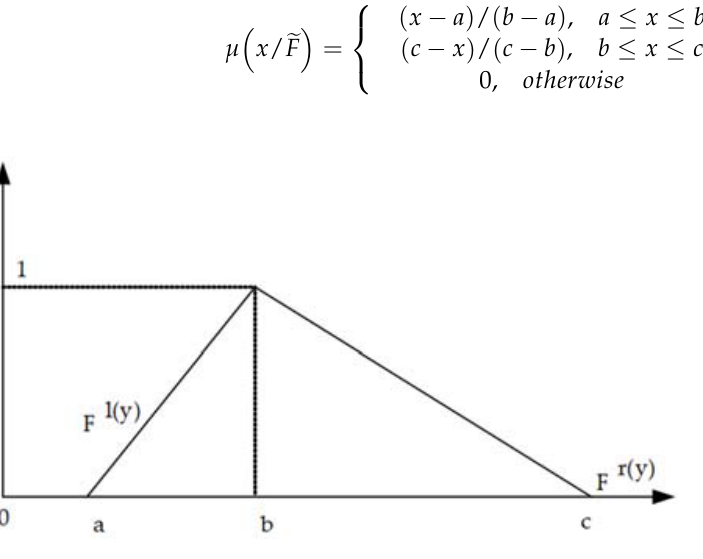
Figure 2. The membership function of TFN.